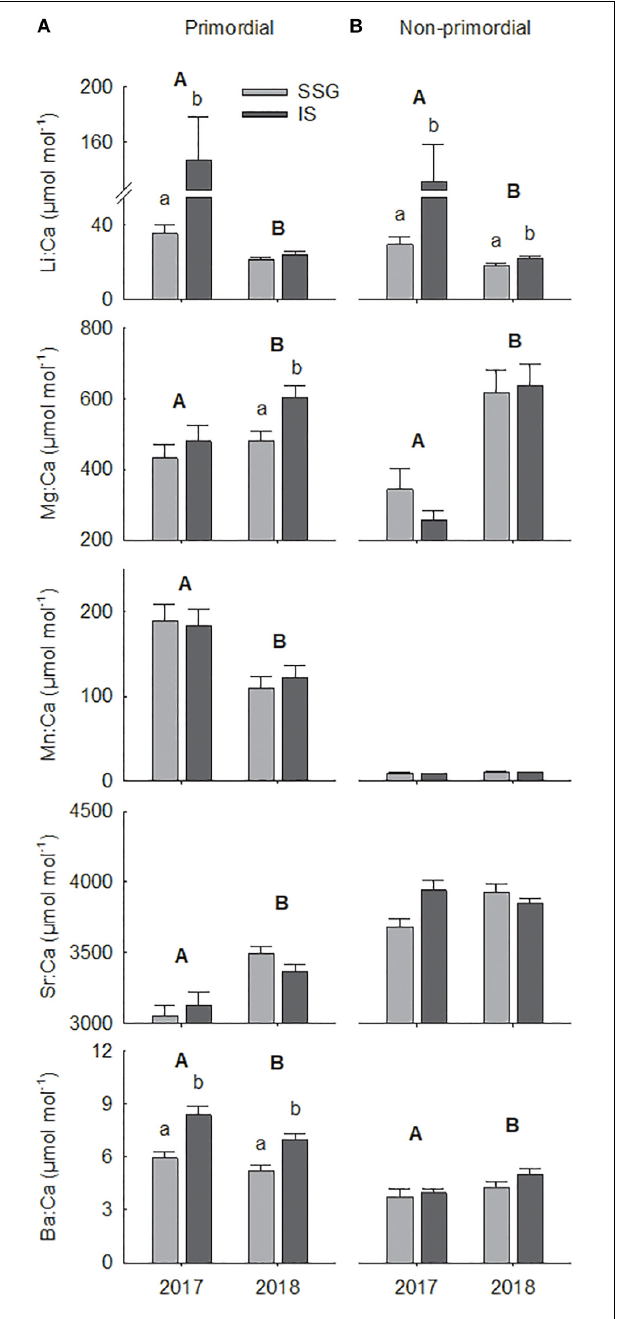
FIGURE 9 | Regional comparisons of mean element:Ca ratios ( µ mol mol - 1 ) for the (A) primordial area and (B) non-primordial area of larval King George whiting otoliths in 2017 and 2018. Letters identify significant differences ( P < 0.05; capitals, between years; lower case, between regions). Error bars are +1 SE. SSG, Southern Spencer Gulf (light); IS, Investigator Strait